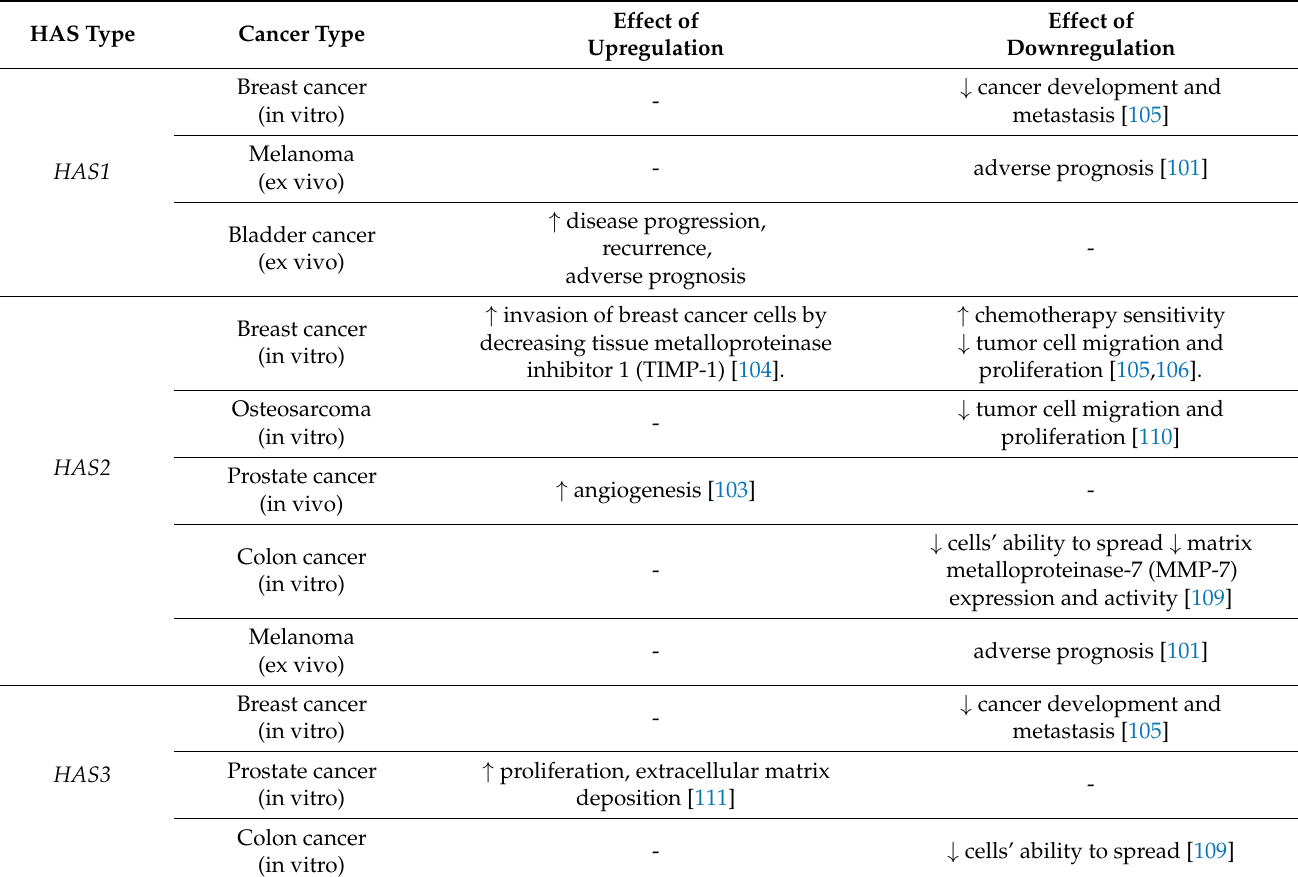
Table 1. HAS expression-dependent effects on cancer